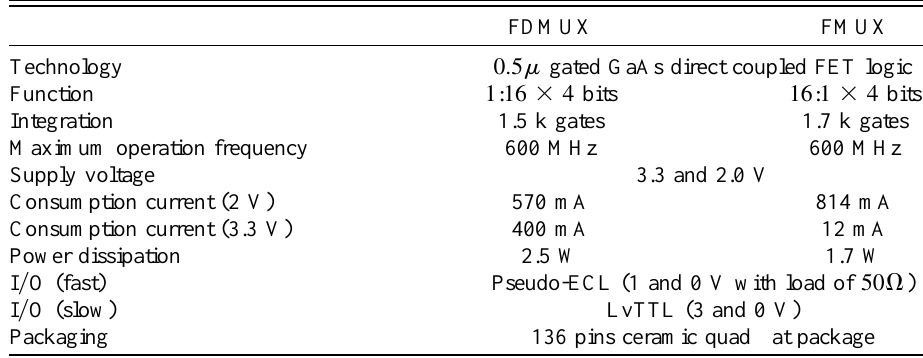
TABLE II. Main specifications for FDMUX and FMUX.